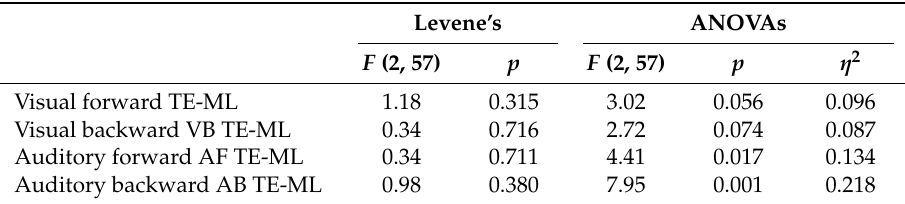
Table 8. One-way ANOVAs with two-error maximum lengths as dependent variables and language groups as independent